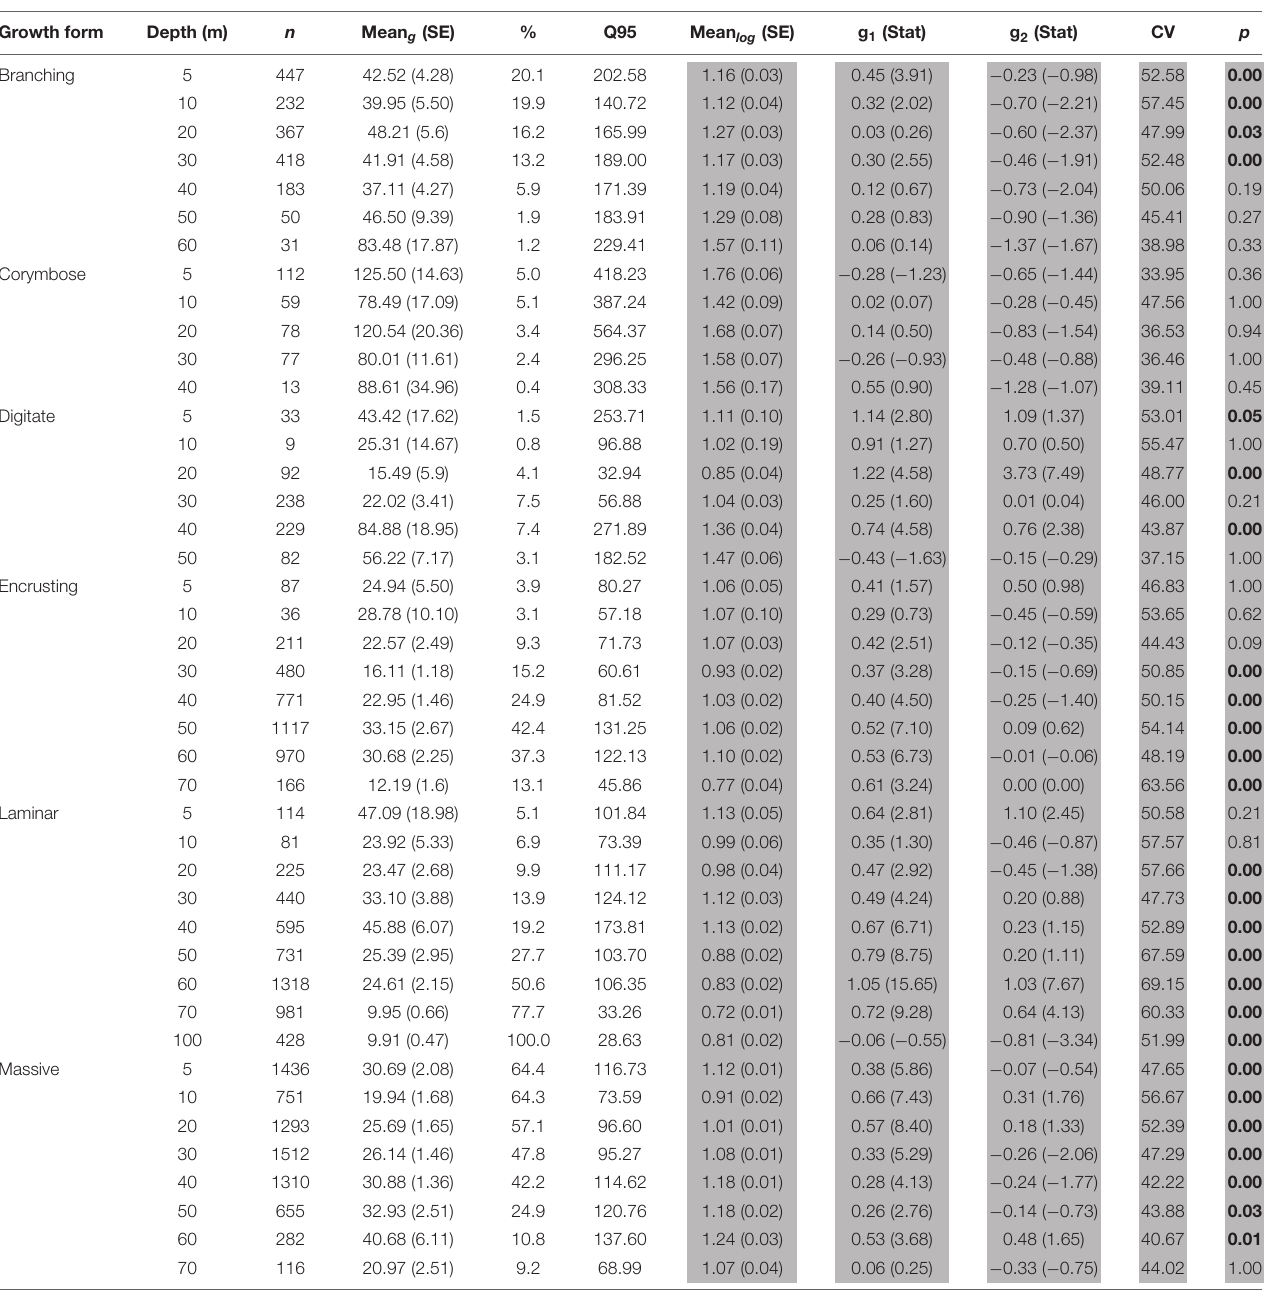
TABLE 1 | Basic statistical summary of untransformed data (white background) and statistical summary of SFD log-transformed colony size (shaded background) based on six growth forms. Growth